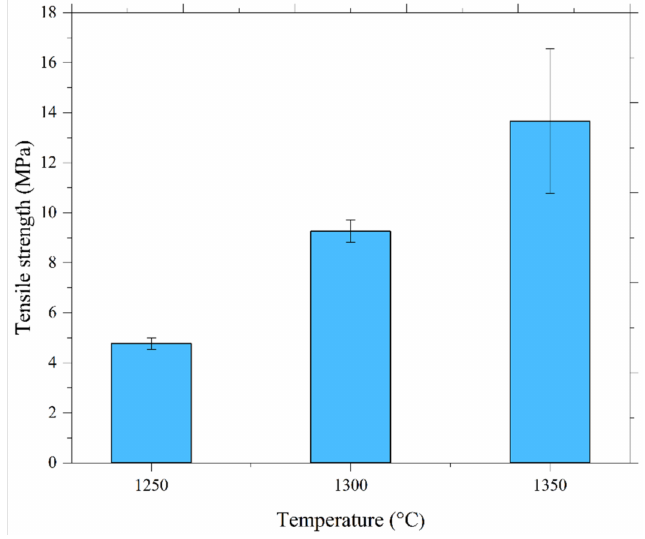
Figure 13. Tensile strength versus sintering